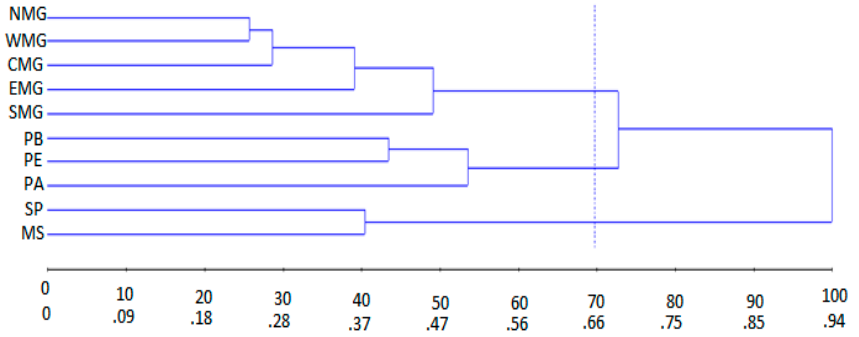
Figure 3. UPGMA dendogram of ten Acrocomia aculeata provenances constructed from genetic distance [36]. Provenances: PA = Pará; PE = Pernambuco; PB = Paraiba; SP = São Paulo; NMG = North Minas Gerais; SMG = South Minas Gerais; CMG = Central Minas Gerais; EMG = East Minas Gerais; WMG = West Minas Gerais; MS = Mato Grosso do Sul. The first row numbers from 0–100 are percentages of dissimilarity; and the second row numbers from 0–0.94 are levels of fusion (average genetic distance) corresponding to percentage of